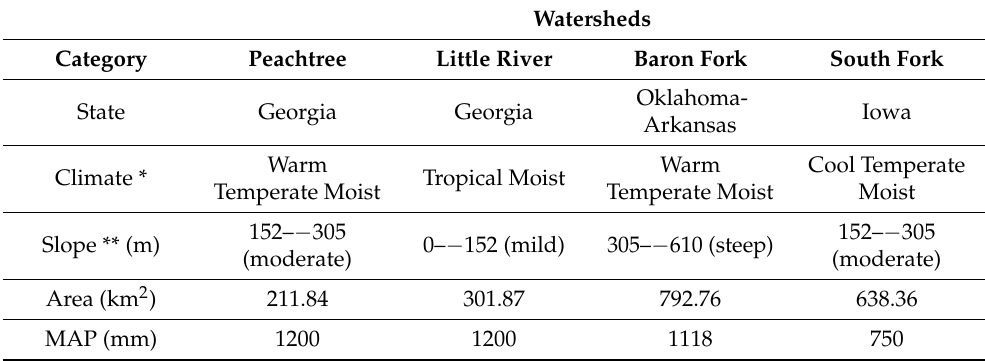
Figure 2. Location map of the four watersheds and their subbasins: ( a ) Peachtree Creek watershed, ( b ) Little River experimental watershed, ( c ) Baron Fork watershed, and ( d ) South Fork watershed. Table 1. Salient features of the four watersheds, including Climate, Slope, Area, and Mean Annual Precipitation (MAP).